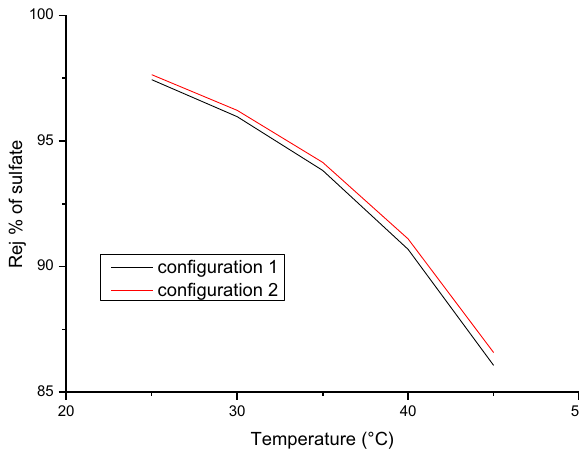
Fig. 15 comparison between conf a and conf 2 on % removal of TDS at optimum feed pressure